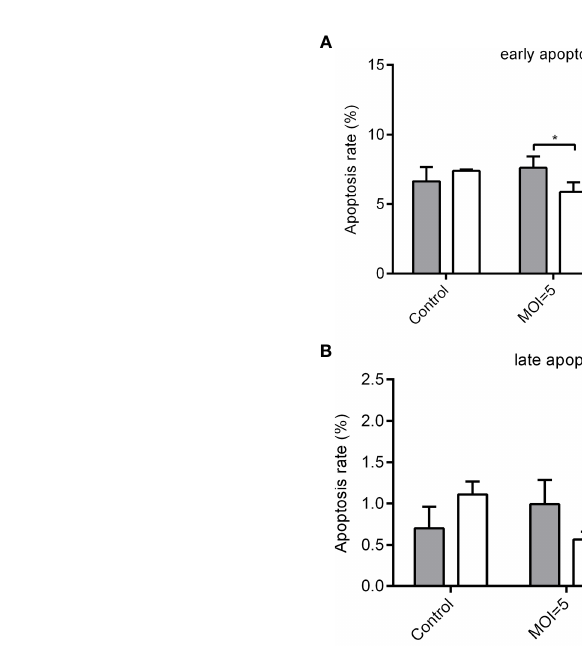
FIGURE 3 | Overexpression of zebra fi sh BIRC2 inhibits the early and late apoptosis in the case of E. piscicida infection. (A) The effect of zebra fi sh BIRC2 on the early apoptosis. (B) The effect of zebra fi sh BIRC2 on the late apoptosis. The EPC cells transfected with p3×FLAG or BIRC2-FLAG were infected with E. piscicida at an MOI of 5, 10 or left untreated. At 6 hpi, samples were collected, then stained with annexin V FITC, and fi nally analyzed by cyto fl ex S Flow Cytometer. Data represented the means ± the SEM (n = 3) and were tested for statistical signi fi cance using a two-tailed student ’ s t- test. * p < 0.05; ** p <